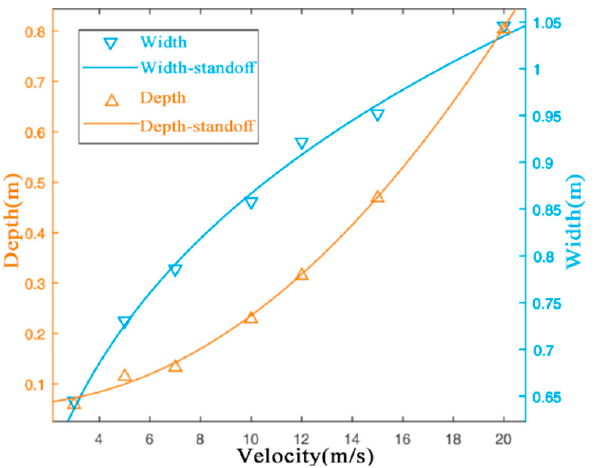
Figure 9. The correlation curve of scouring performance and flow rates. It can be seen from the figure that as the flow rate increases, the scouring depth and width will increase, while the time for the scouring depth to stabilize will become longer. Once the flow rate is greater than 10 m/s, there will be two scouring effects—that is, the scouring depth will increase again, which is unfavorable. Therefore, the flow velocity is selected as 7 m/s in the subsequent experiments—that is, the flow rate is 1.187 m 3 /min.